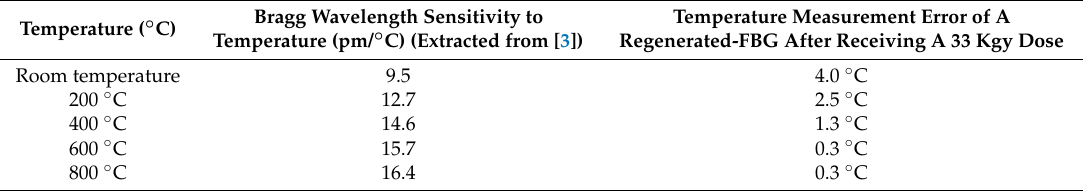
Figure 4. X-ray radiation-induced Bragg wavelength shift measured at different temperatures. The heated regenerated FBG received a total dose of 33kGy after 6 h at an average rate of 92 Gy/min. The reference FBG at room T ◦ [M4] received a dose of 148 kGy at an average rate of 414 Gy/min. The T ◦ compensation data used at 200 ◦ C was partly extrapolated due to a failure in the acquisition. The absence of temperature stabilization and compensation for the curves at room T ◦ explains their higher fluctuation. Table 1. Radiation-induced error on temperature measurements made with a regenerated